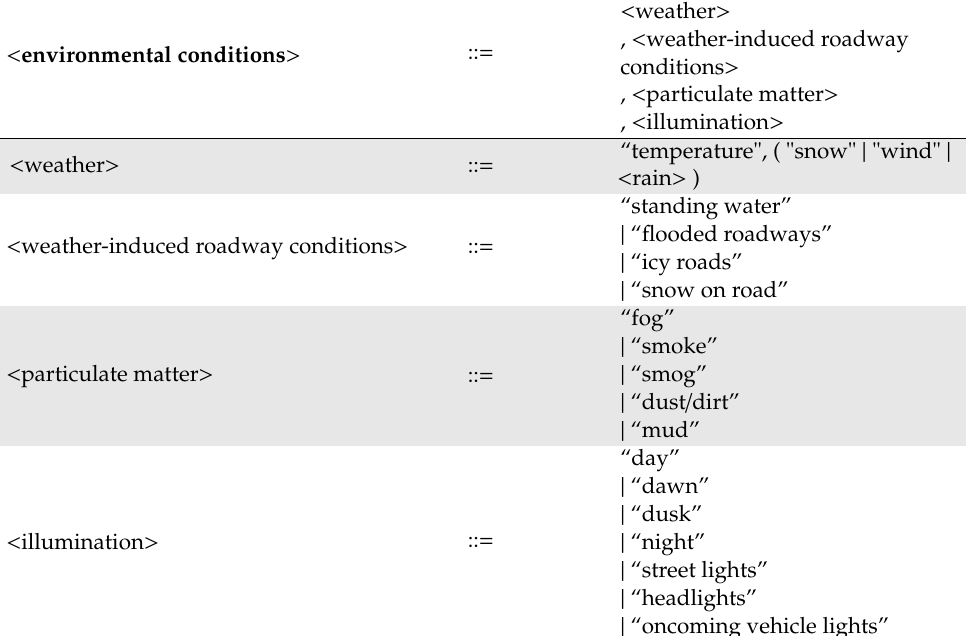
Table A5. The 3rd stage of < environment >< environmental conditions >